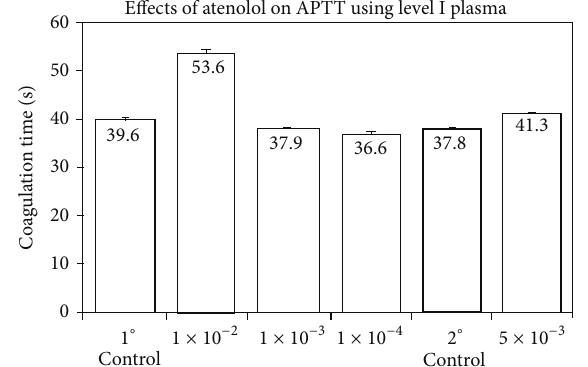
Figure1:EffectsofatenololuponAPTTusingLevelIplasma( 𝑛 = 4 ; 𝑃 = 0 for 1 × 10 −2 M and 5 × 10 −3 M atenolol) ( 𝑛 = 4 ; 𝑃 = 0.07 for 1 × 10 −3 M atenolol and 𝑃 = 0.01 for 1 × 10 −4 M atenolol).